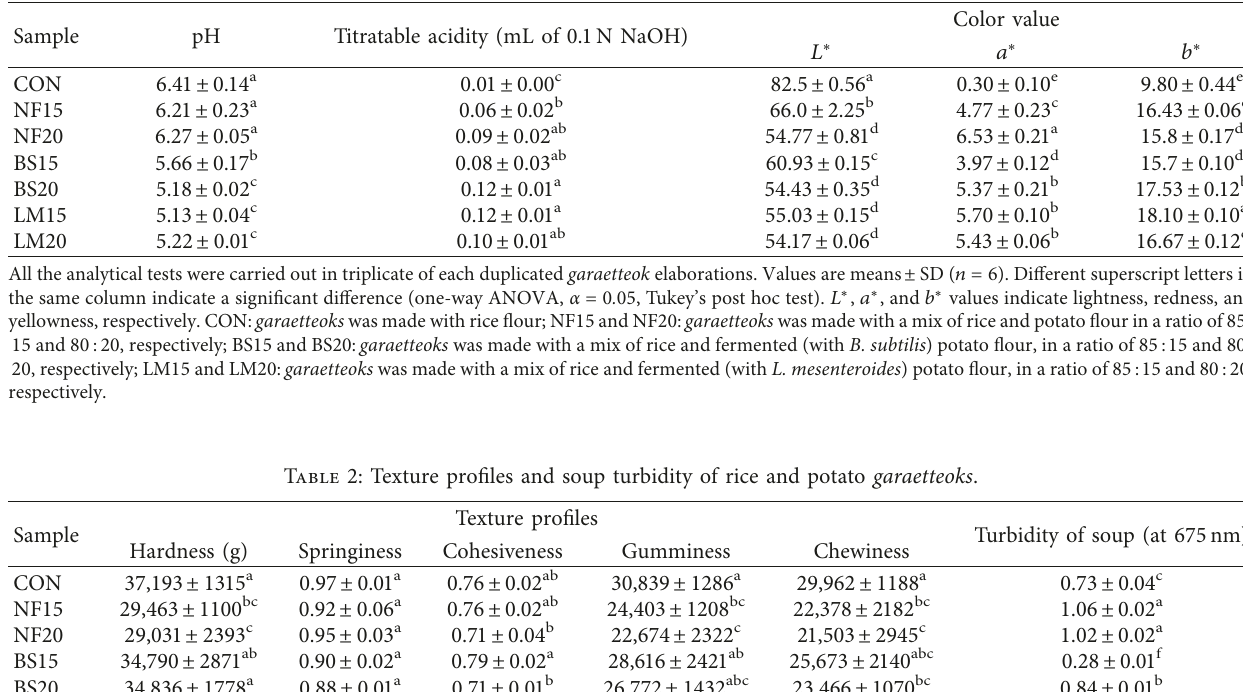
Table 1: The pH, titratable acidity, and Hunter color values of rice and potato garaetteoks .